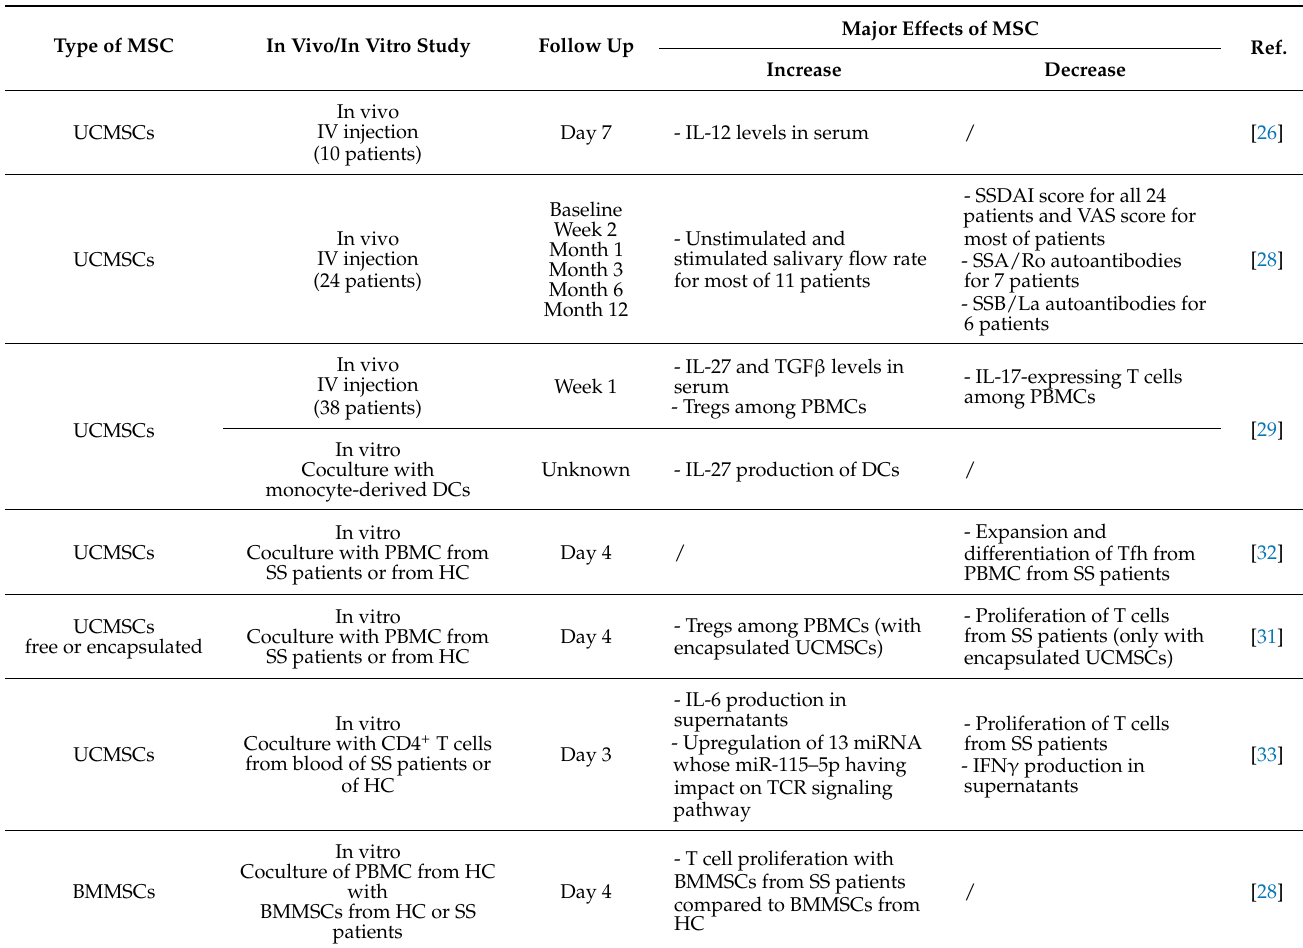
Table 2. The in vivo and in vitro studies of MSC treatment in SS